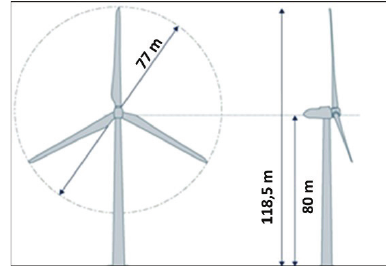
Figure 5. Model GE 1.5sle of a wind turbine that was